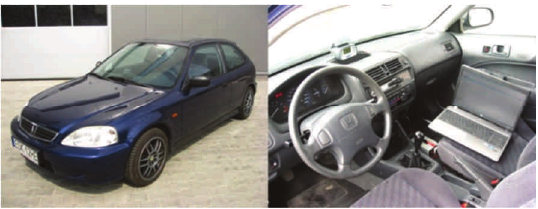
Fig. 1. Vehicle used in the empirical